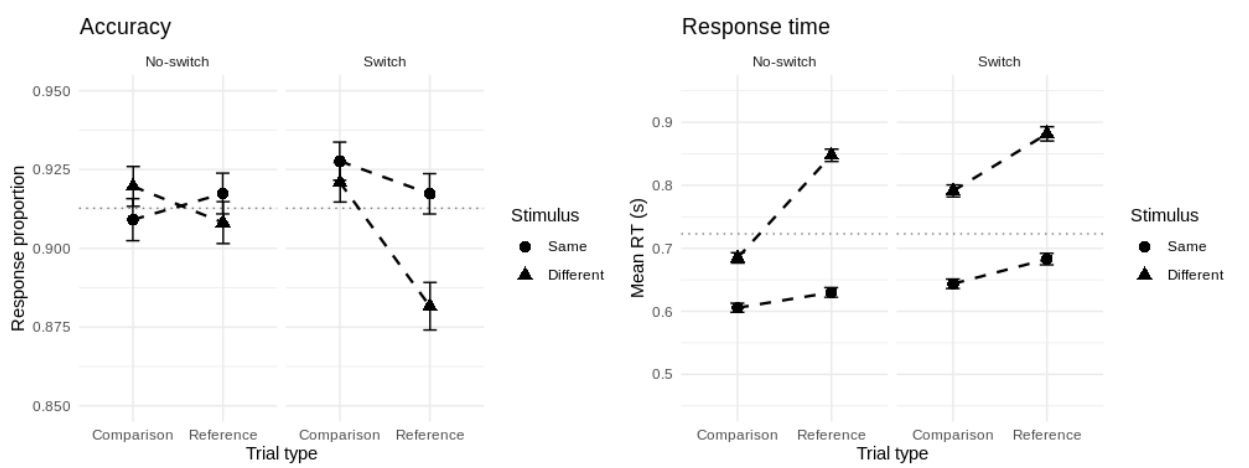
Figure 3. Group-averaged accuracy ( left panel ) and mean RT ( right panel ) for each cell of the experimental design. Error bars represent 95% confidence intervals.